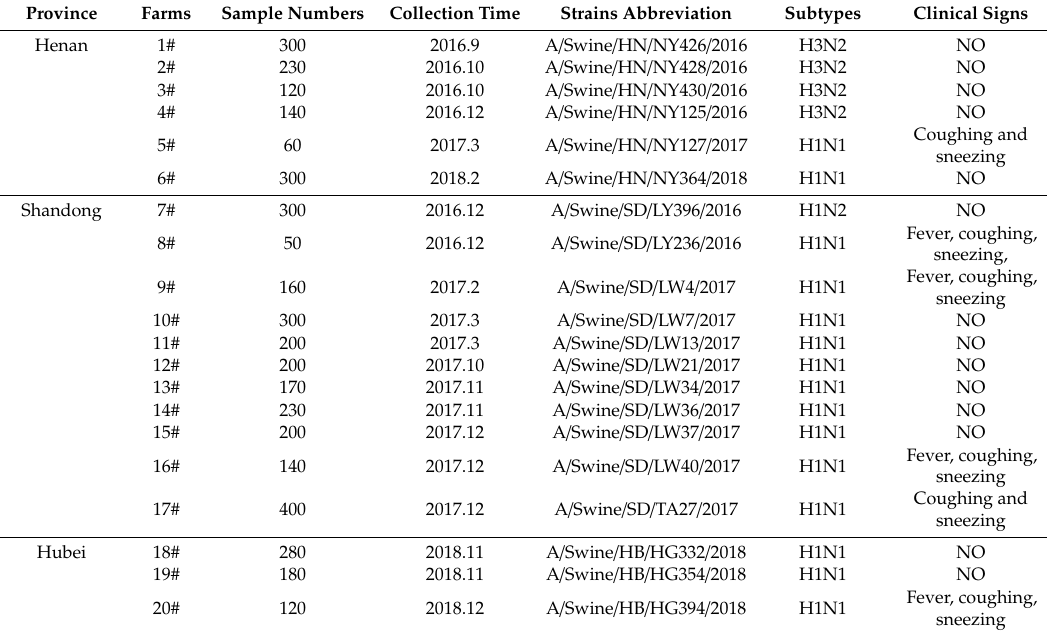
Table 1. Information of samples collected for IAV-S